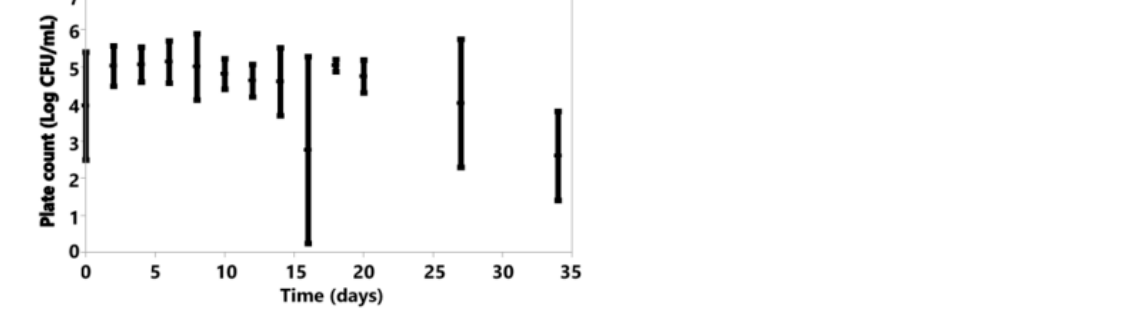
Figure 6. Plotted values represent means, and error bars represent standard deviations for A. pullulans ( A ), B. bruxellensis ( B ), B. claussenii ( C ), D. anomala ( D ), K. lactis ( E ), K. marxianus ( F ), M. genevensis ( G ) under oxic conditions; all of which were calculated from three replicates for each species.